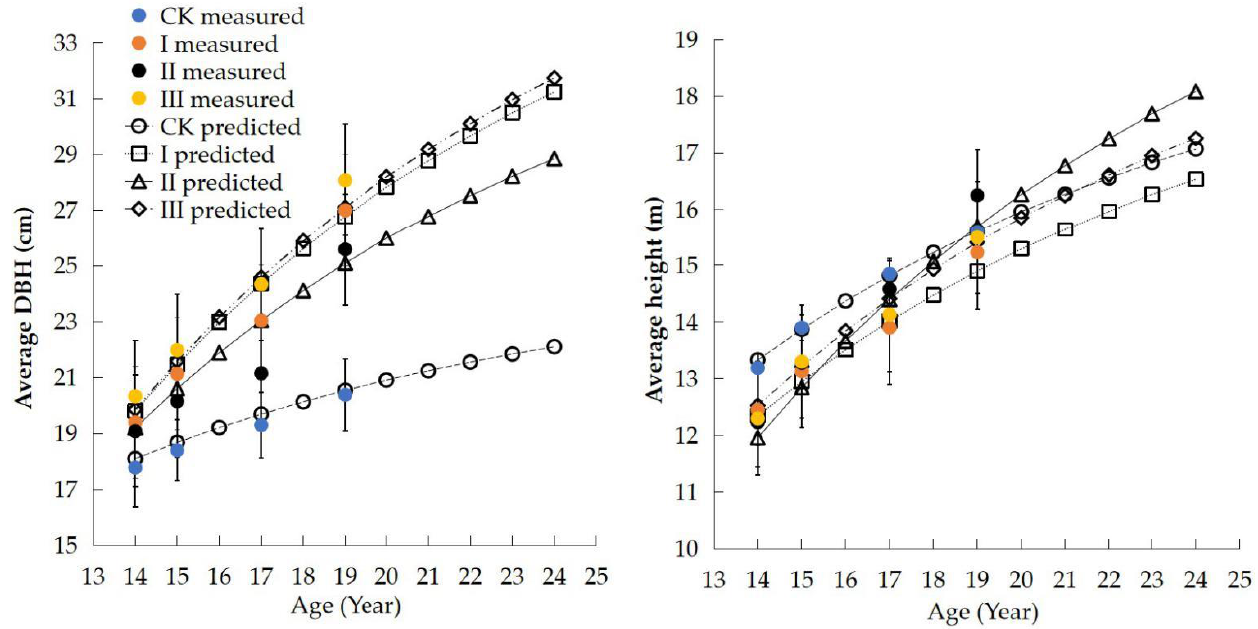
Figure 3. Comparison of the average height and DBH between the predicted (by the CROBAS model) and measured values.